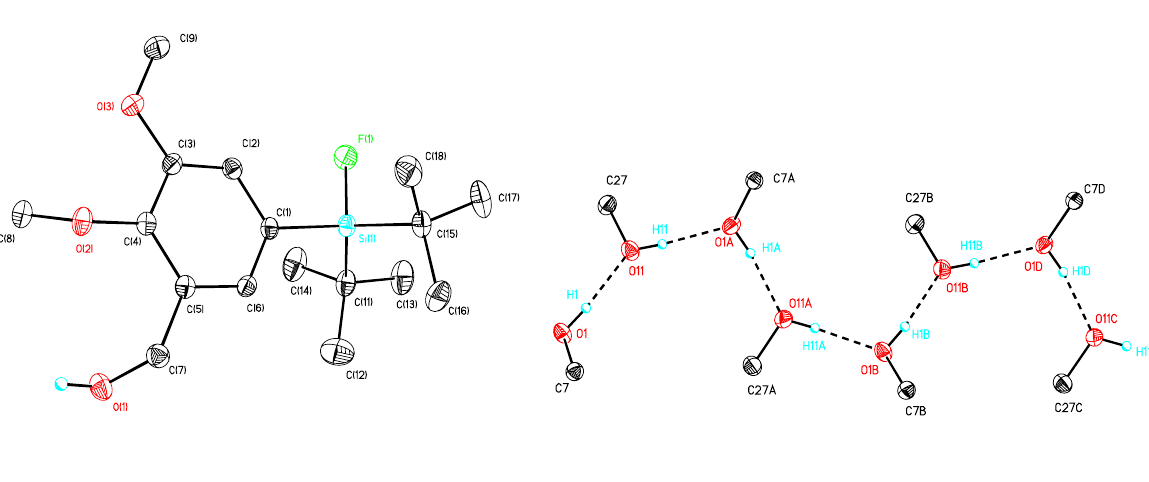
Figure 3. Molecular structure of 10b (left) and simplified representation of the intermolecular hydrogen bridges (right). Atomic displacement parameters are drawn at 30% probability